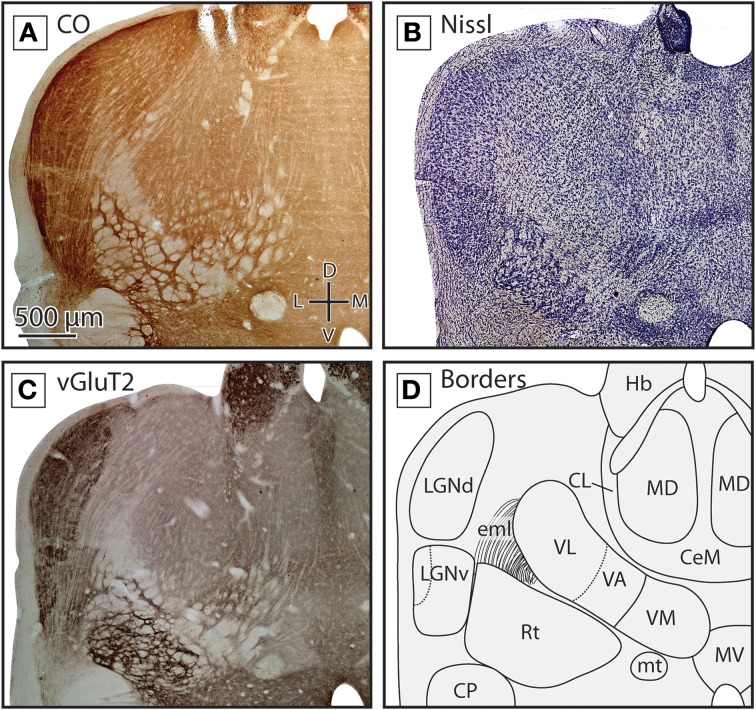
Boundaries of nuclei in rostral sections of the dorsal thalamus in the short-tailed opossum. Three different stains were used to delineate the boundaries of thalamic nuclei including CO (A) Nissl (B) and vGluT2 (C). Reconstructions of thalamic nuclei derived from these stains are drawn in (D). Midline nuclei, including CeM, CL and MD, can be observed using each stain, but are most obvious in Nissl and vGluT2. Ventral and lateral to midline nuclei, VL, VA, and VM can also be seen. VA and VM boundaries are most apparent in vGluT2 (C). Lateral to these structures, LGNd and LGNv can be identified. The boundaries of these structures can be readily identified in CO (A) and vGluT2 (C) stained tissue. In all images, dorsal is up and lateral is to the left. Scale bar in (A) is 500 μm, and is the same for all images.